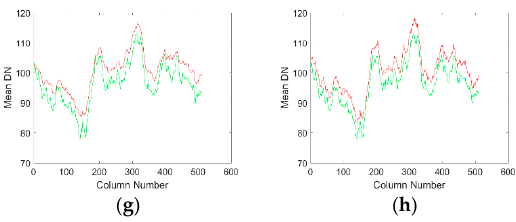
Figure 11. Mean cross-track curves of various denoising results, where the green curve in each result is the mean cross-track curve of the original image, and the red curve is the mean cross-track curve of various denoising results. ( a ) Original image; ( b ) WAFT; ( c ) UTV; ( d ) ASSTV; ( e ) VSNR; ( f ) SILR; ( g ) ℓ (cid:2868) sparse; ( h ) LRSUTV.